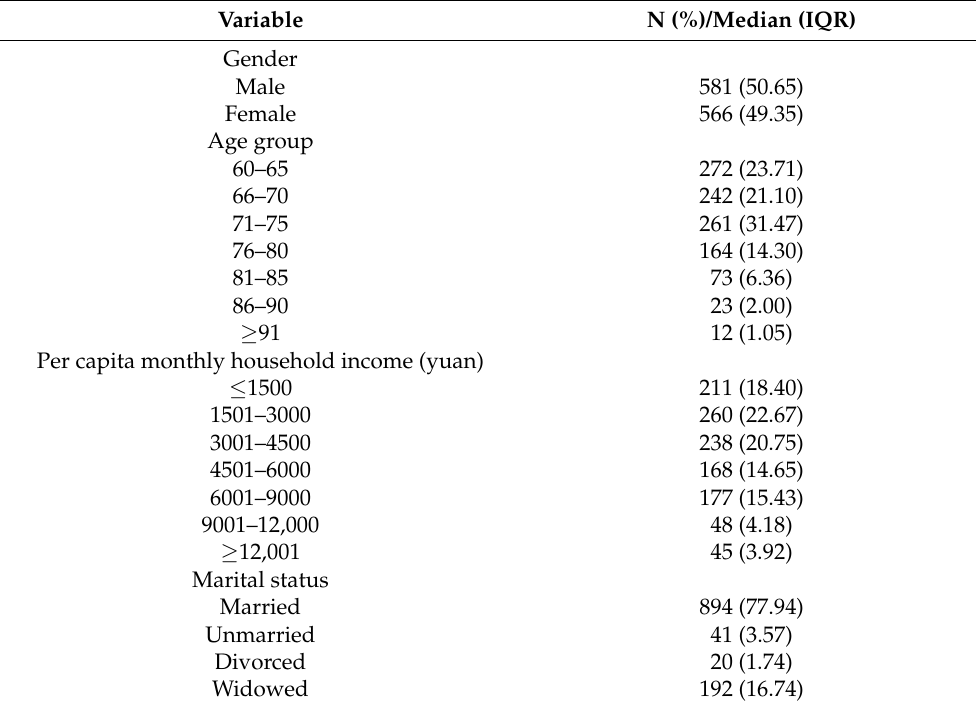
Table 1. Descriptive statistics of